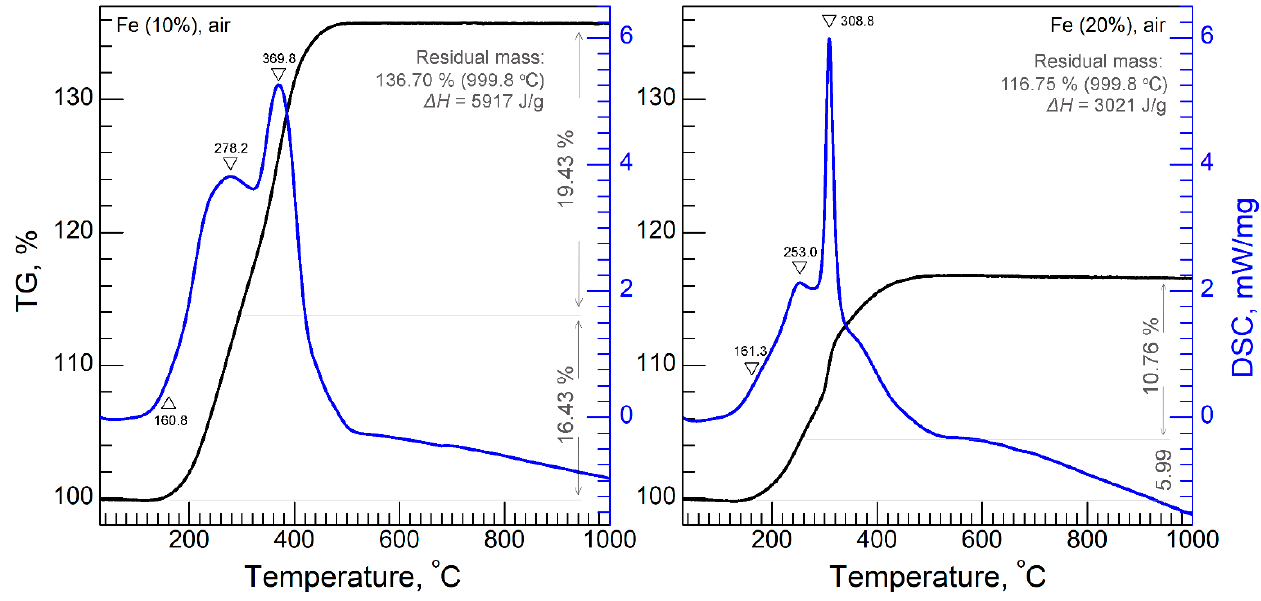
Figure 4. STA analysis of Fe 10% and Fe 20% powders in air.